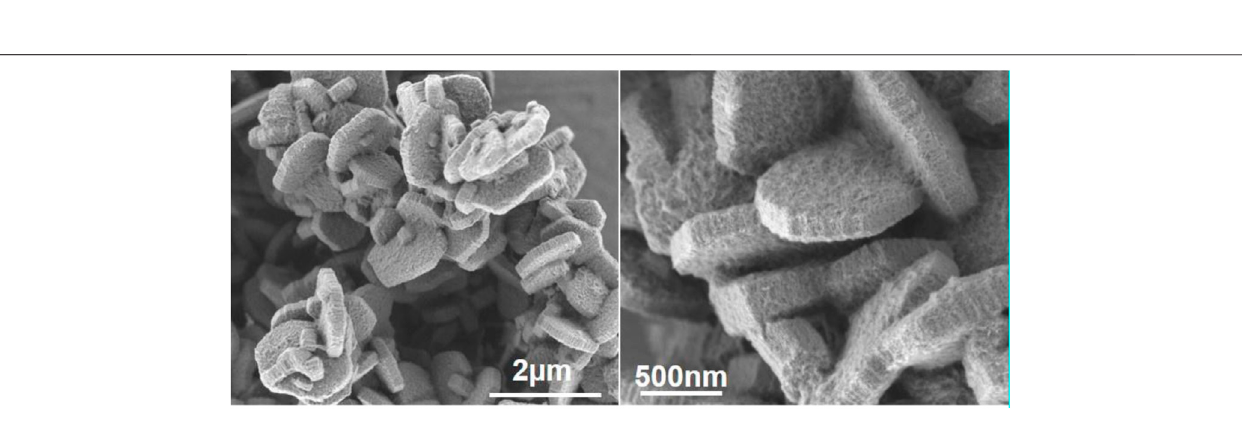
Frontiers in Chemical Engineering |